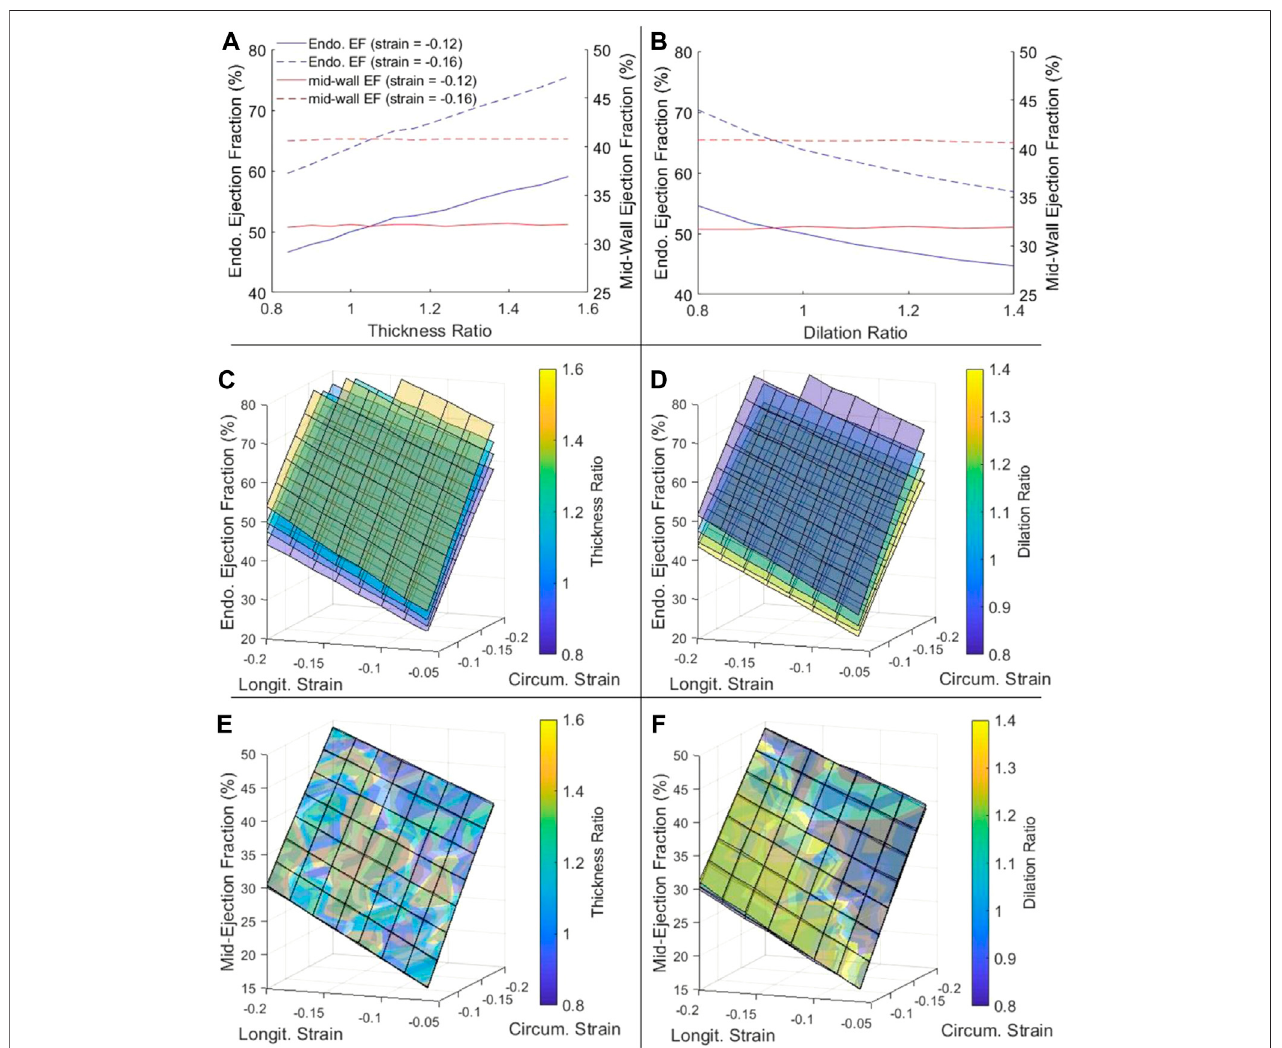
FIGURE3|(A,B) Thedependency ofendocardialEFandmid-wallEFon (A) myocardialthicknessratioand (B) chamberdilation ratio,whenstrainsatthemid-wall layer were fi xed at either − 0.12 or − 0.16. (C – F) The complete dependency of (C,D) endocardial EF and (E,F) mid-wall EF on thickness ratio (four ratios from purple to yellow are 0.84, 1.00, 1.16 and 1.40), dilation ratio (four ratios from purple to yellow are 0.8, 1.0, 1.2 and 1.4), and longitudinal and circumferential strains at the mid- wall